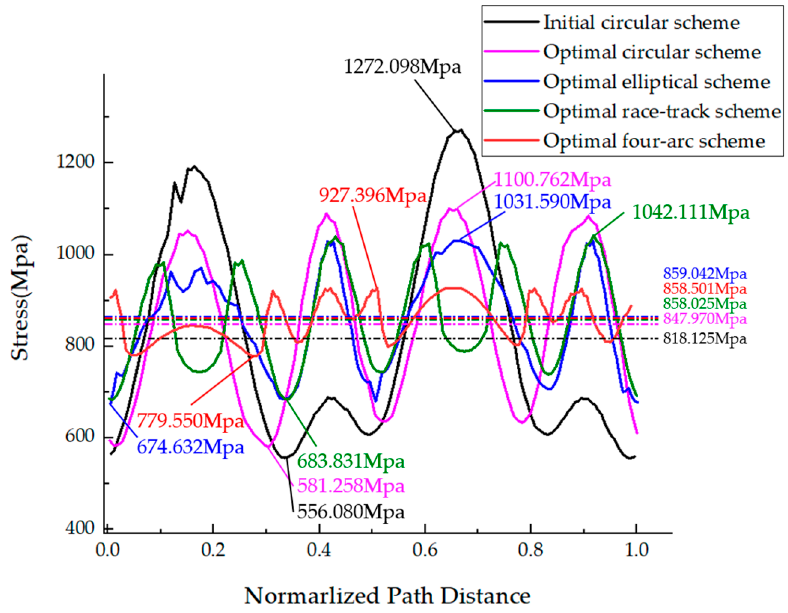
Figure 10. Von Mises stress distribution along the edges of the vent holes of the initial circular and four optimal schemes. Table 5. Maximum, minimum, mean, and range (difference between the maximum and minimum values) values of the von Mises stress along the edges of the vent holes of the initial circular and four optimal schemes.